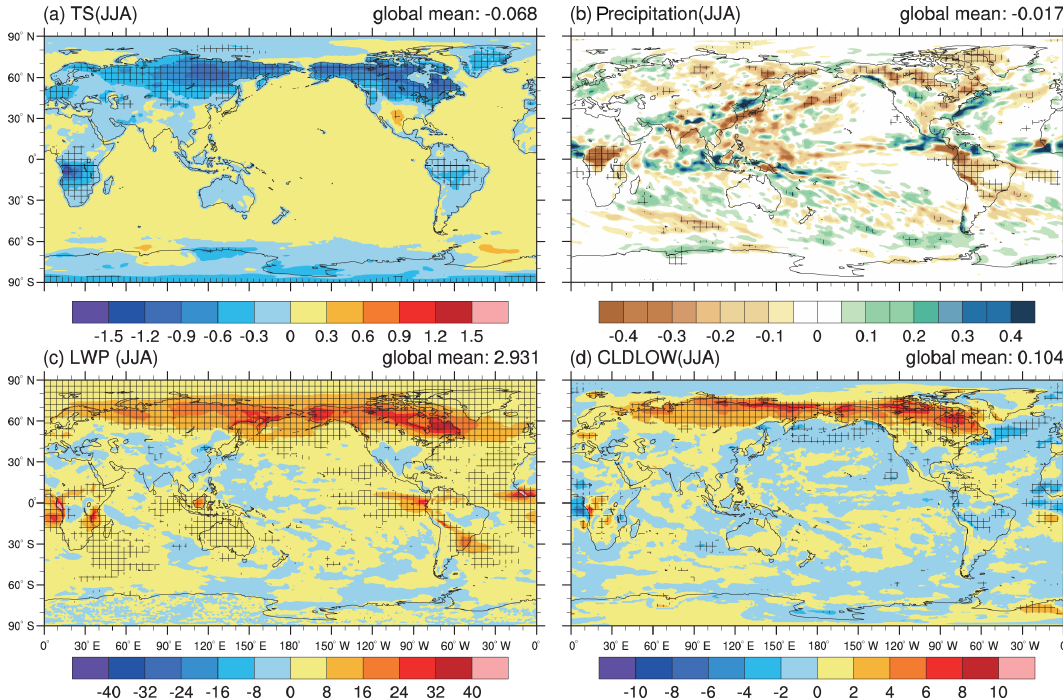
Figure 12. Changes in (a) surface air temperature ( T s , in K), (b) total precipitation (mmd − 1 ) , (c) cloud liquid water path (LWP, in gm − 2 ) and (d) low-level cloud cover (CLDLOW, in %) due to all fire aerosols in the boreal summer (JJA) averaged for the period of 2003–2011. The plus signs denote the regions where the change is statistically significant at the 0.1